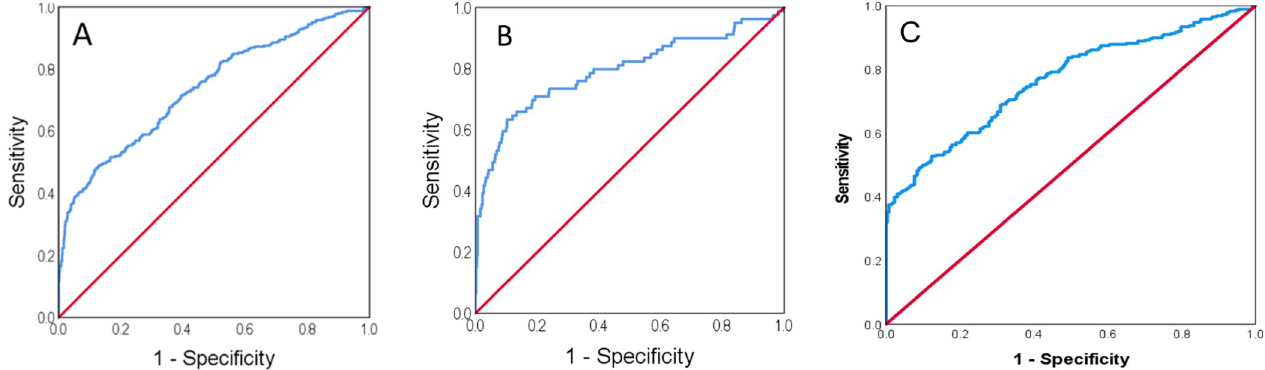
Fig 4. The receiver-operating curve of the admission CRP/ troponin ratio for the diagnosis of perimyocarditis against STEMI and NSTEMI, or all acute myocardial infarction patients (A, AUC- 0.74, CI: 0.7–0.77, p < 0.0001) or against STEMI patients only (B, AUC- 0.73, CI: 0.69–0.76, p < 0.0001). Figure abbreviations are the same as in Fig